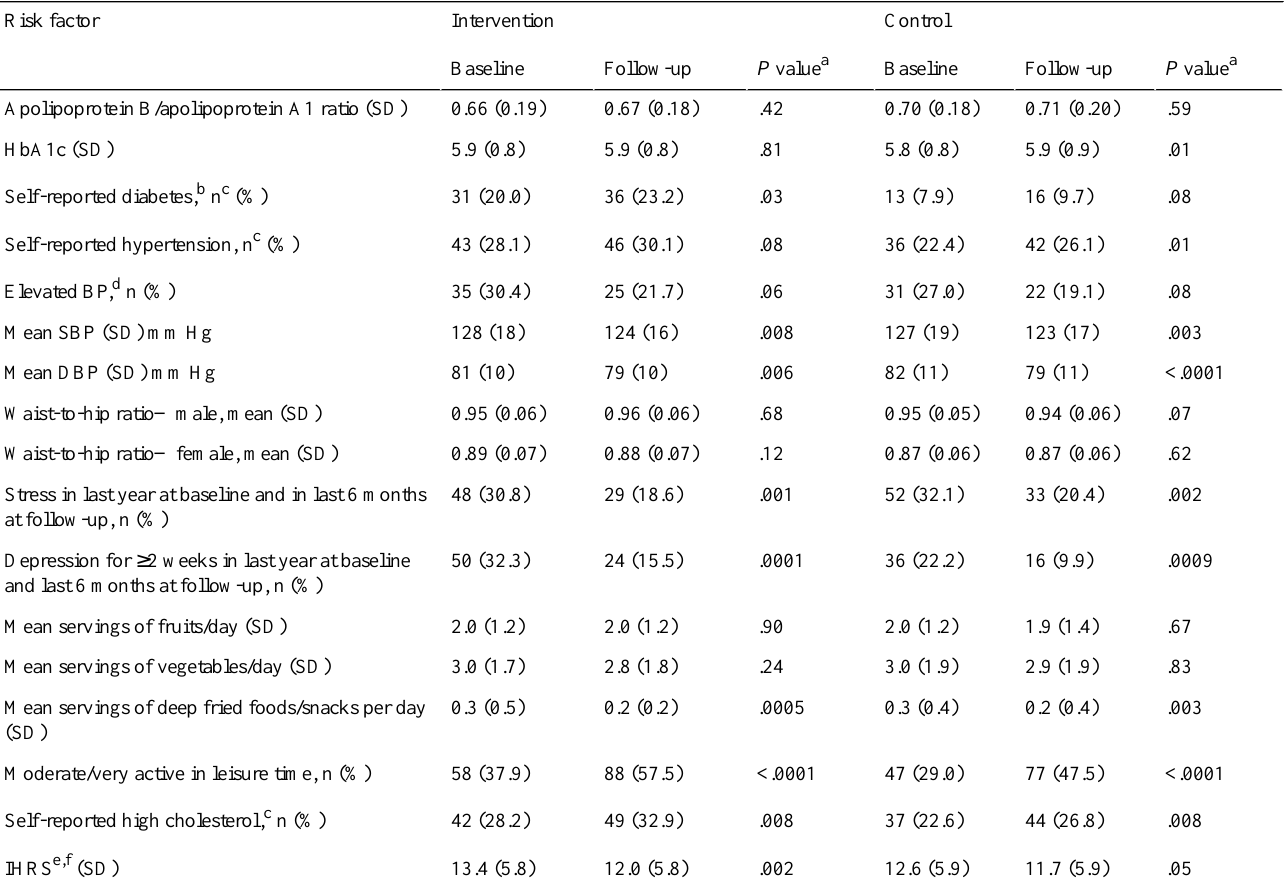
Table 2. Baseline and follow-up risk factors in intervention and control